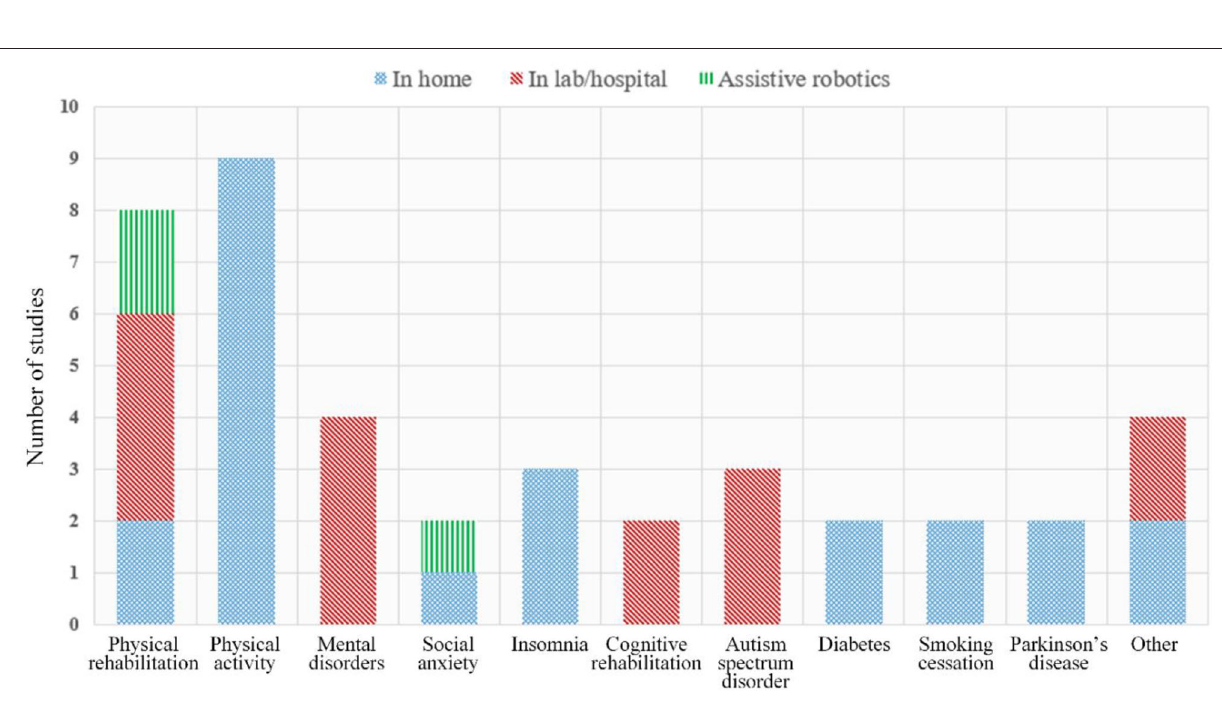
Frontiers in Digital Health |